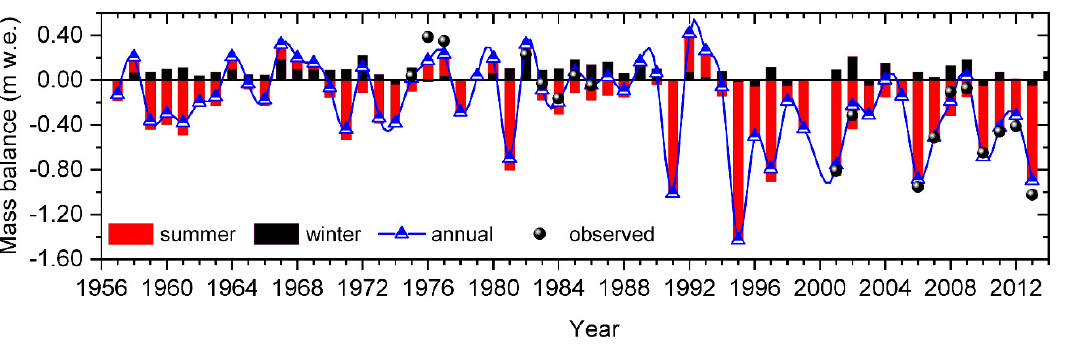
Figure 7. The simulated and observed annual SMB and the seasonal glacier SMB series of Qiyi glacier,